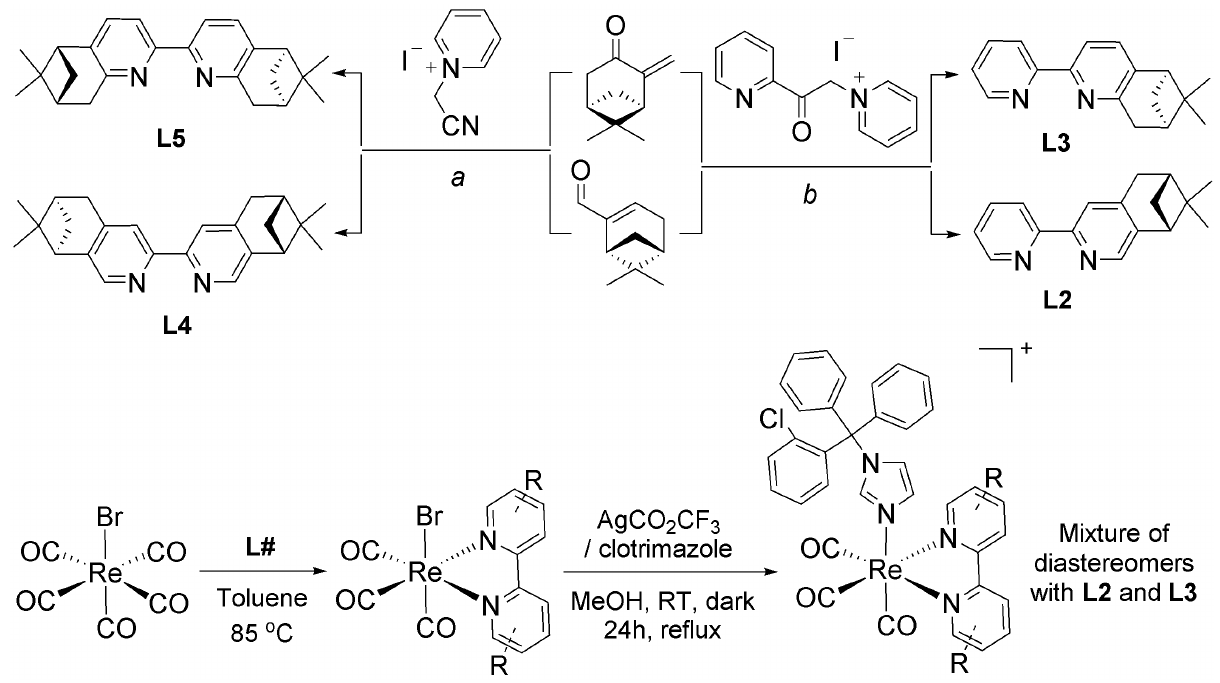
5 of 17 Figure 3. Molecular structure of Re-ctz complexes used for molecular docking with receptor SaMurG. Note that the # refers to the complexes. The corresponding 4,5-pinene and 5,6-pinene bi- pyridine are referred as L# in the text. The * refers to the specific nitrogen atom coordinated to the Re center as depicted for the complex on the top left. 2.2. Synthesis and Characterization of Complexes Following prescreening identification of the new potential antibiotic complexes, we moved to the preparation of the candidate molecules. The 4,5-pinene and 5,6-pinene bi- pyridine ligands ( L2 – L5 in Scheme 1) were synthesized according to established proce- dures [47,53]. Ligands L2 and L3 were prepared in a single step from the reaction of nat-